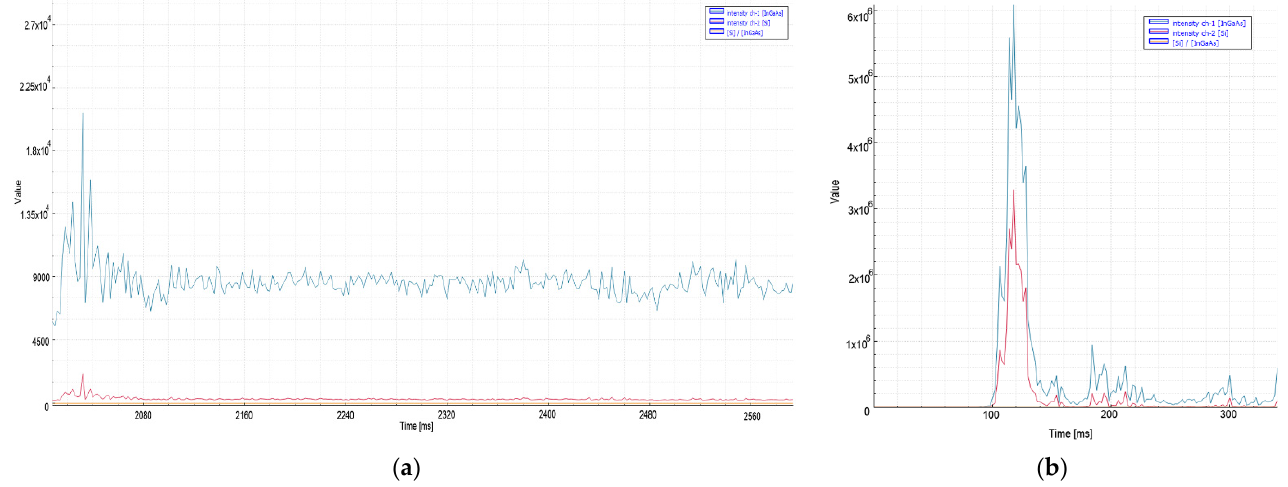
Figure 5. Measurement values recorded during nitrogen cutting of 8 mm aluminum material: ( a ) quality cut with ideal parameters, ( b ) the moment of deterioration of cut and quality.